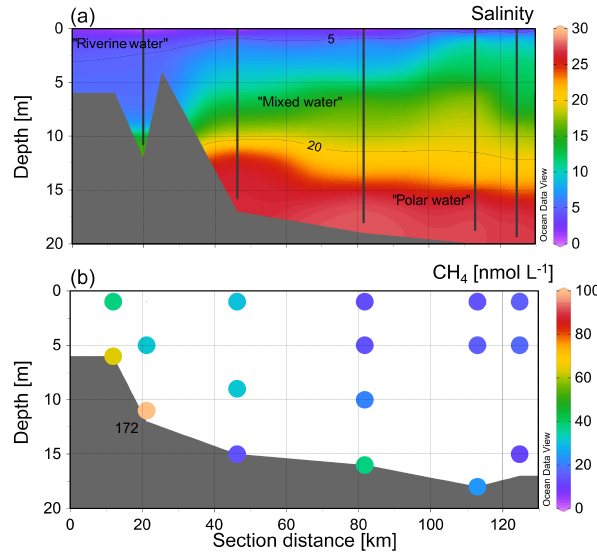
Figure 2. Salinity (a) and methane ( b , in nmol L − 1 ) distributions vs. depth and distance from the shore for Transect 1. In (a) the water masses are also indicated, defined as riverine water (salinity ( S ) < 5), mixed water (5 < S > 20), and polar water ( S > 20). The grey bars indicate the location of the stations. In (b) , for stations with very high methane concentrations, the values are annotated in the